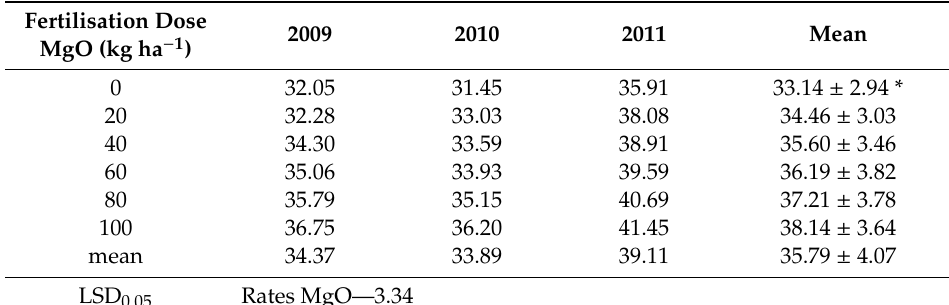
Table 2. The total yield of potato tubers (t ha − 1 FW) depending on Mg fertilisation. Fertilisation